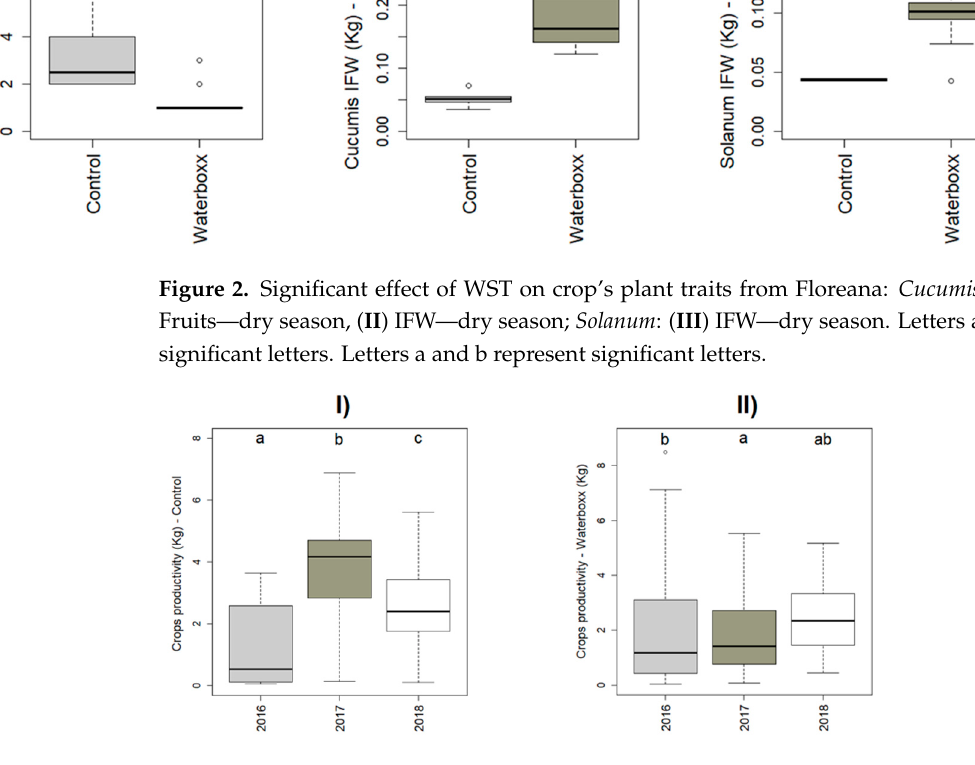
Figure 3. Effect of the research year on crop’s productivity, differentiated by treatment. The data are merged with Capsicum , Cucumis and Solanum information from both islands (Floreana and Santa Cruz). ( I ) Control treatment, ( II ) Groasis Waterboxx ® treatment. Letters show significant results among years within treatments.